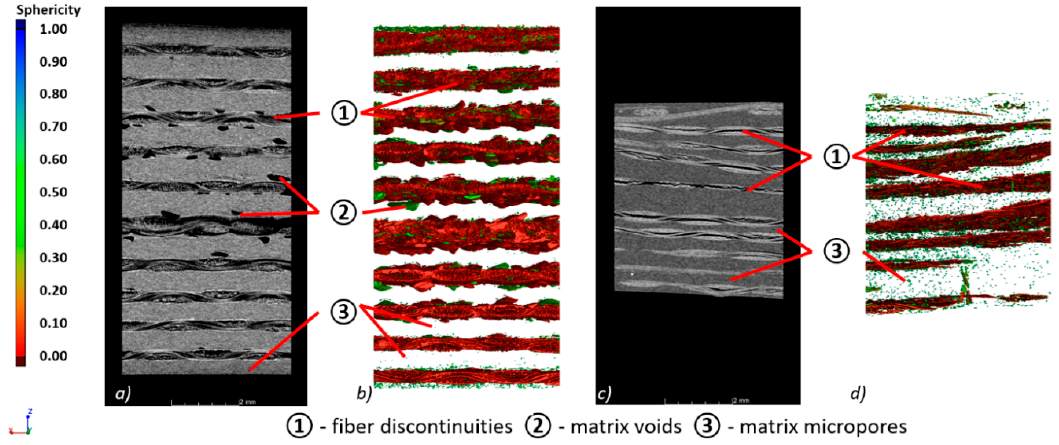
Figure 11. Internal structure of PMCs, ( a ) 2D view of the PEHD sample, ( b ) 3D view of the PEHD sample, ( c ) 2D view of the PP sample, ( d ) 3D view of the PP sample.